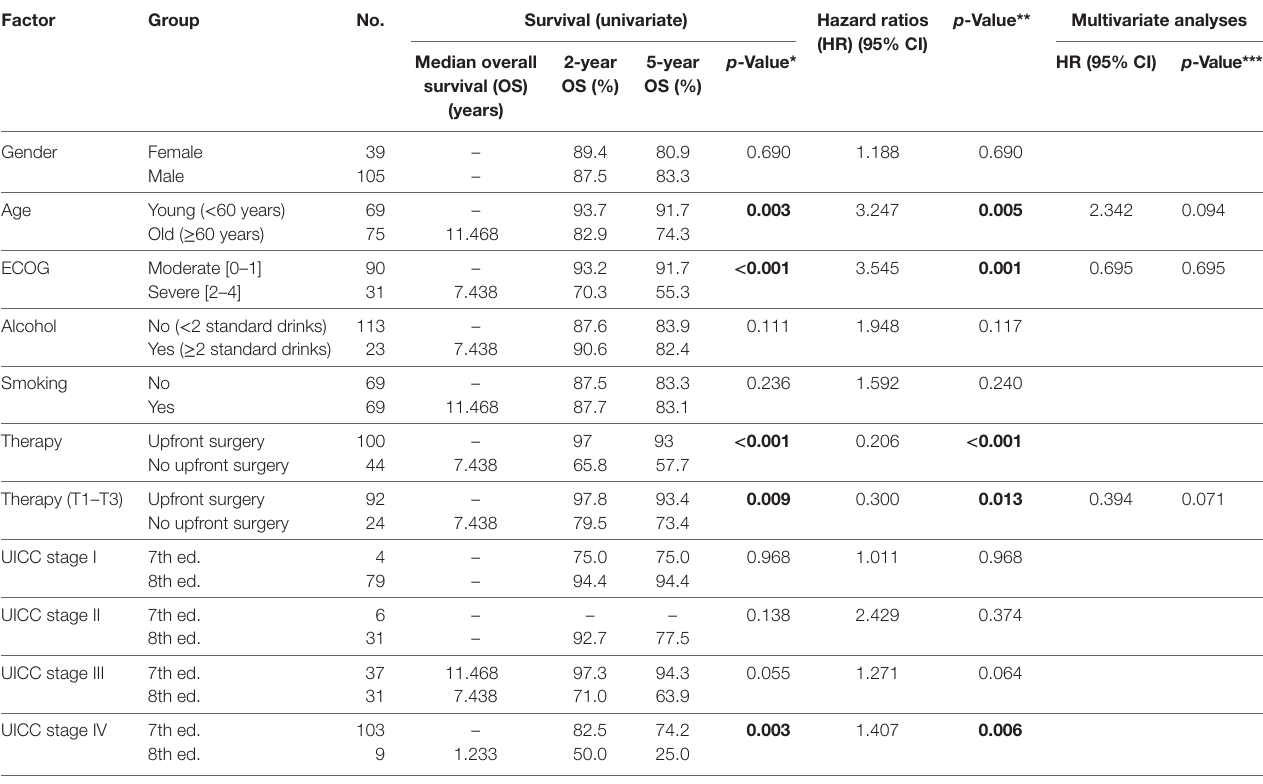
taBLe 4 | Prognostic factors for survival in human papilloma virus-associated cancer of the oropharynx. Factor